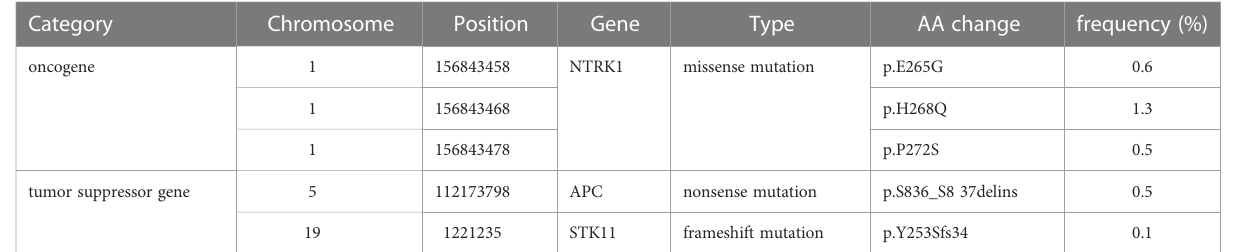
TABLE 1 Mutations in cancer-related